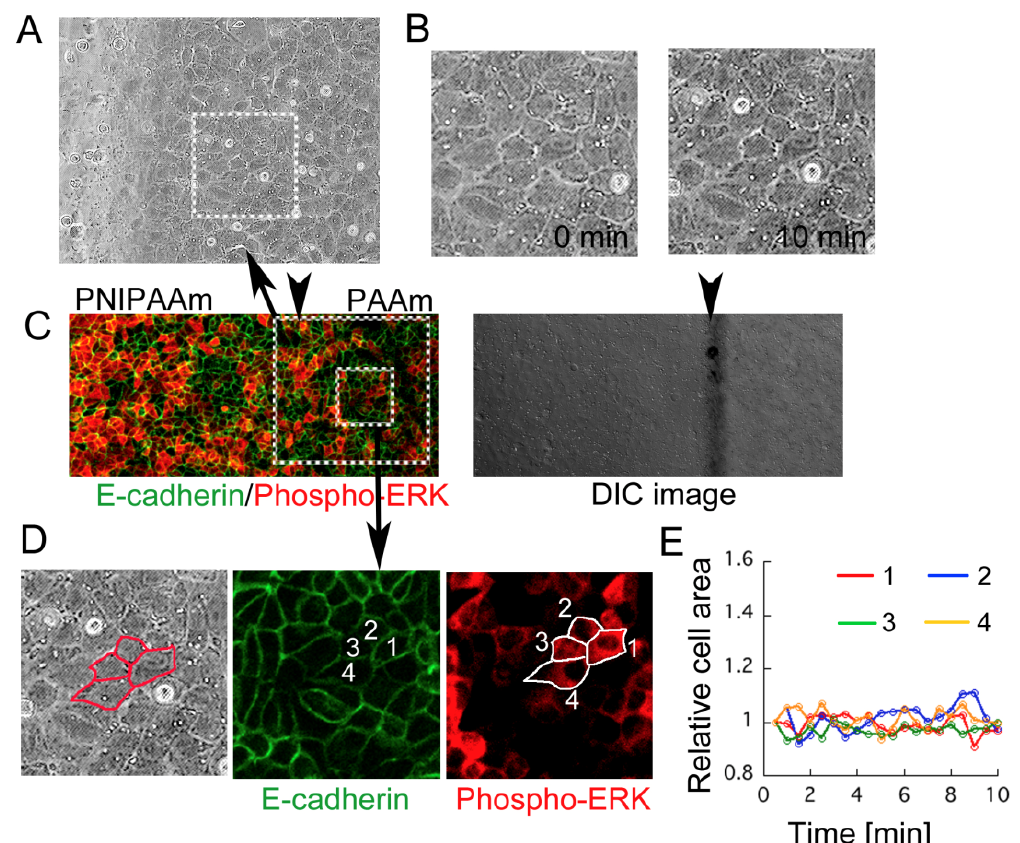
Figure 7. ( A ) Representative picture of the cells on near the border section after 10 min temperature decrease, which used for video-microscopy (supplementary Movie 2). The anchored section is left edge of the image; ( B ) Representative images show in magnified picture of 0 min and 10 min of temperature decrease for insert areas outlined in ( A ). No particular deformation of cells was observed; ( C ) Immunostaining of phosphorylated ERK1/2 and E-cadherin of cells on an around border section used in the video-microscopy. Arrowheads indicate the anchored section of two gels, confirmed by differential interference contrast (DIC) image. Large insert area indicates the section observed by video microscopy ( A ) and smaller insert area is enlarged to ( D ); ( D ) An example images of cellular shape for quantification from video-microscopy. Cellular area was estimated from sequential images acquired by video-microscopy after confirming cells were phosphorylate ERK positive; ( E ) Relative cell areas were plotted as a function of time after temperature decrease. Four phosphrylate ERK positive cells were chosen and analyzed. No particular deformation was observed as compared to cells on NIPAAm side (Figure 4C). Each color and shape on the plot corresponds to data of a single cell numbered of ( D ). Scale bar: 50 μ